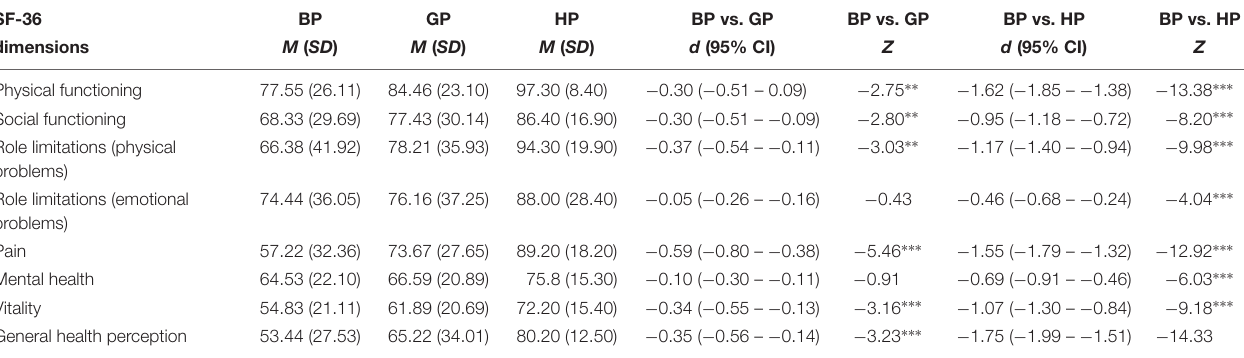
TABLE 1 | Descriptive statistics and comparisons between bariatric patients ( N = 90), general population ( N = 2031), and healthy population ( N = 608). SF-36